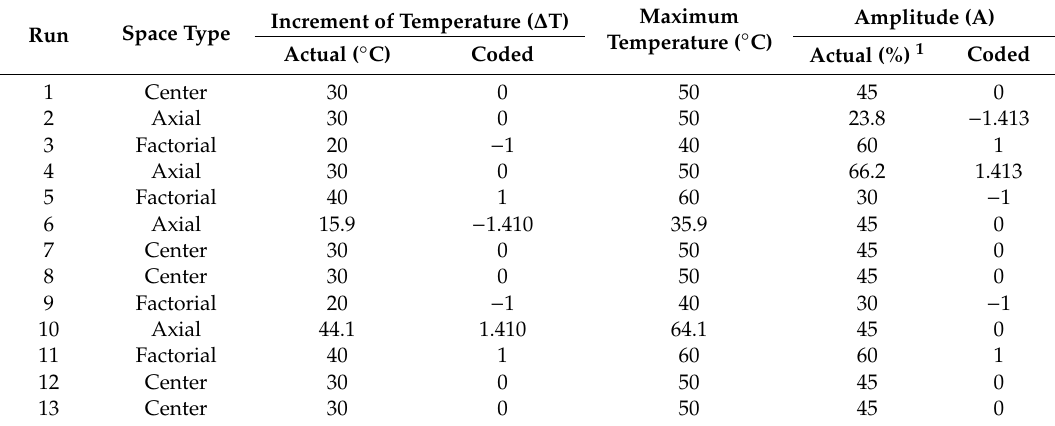
Table 1. Central composite design (CCD) expressed in terms of actual and coded factors used for optimization of ultrasound-assisted extraction (UAE) conditions and maxima operating